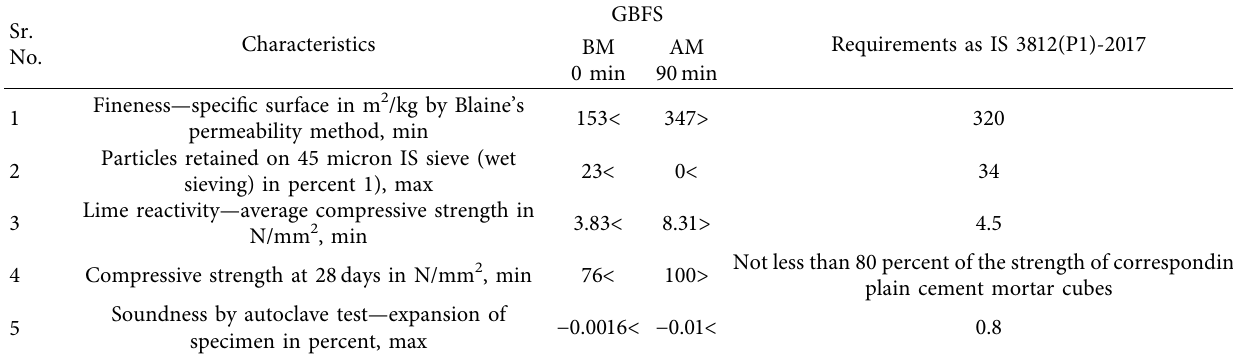
Table 3: Physical characterization of GBFS with respect to IS 3812(P1)-2013.